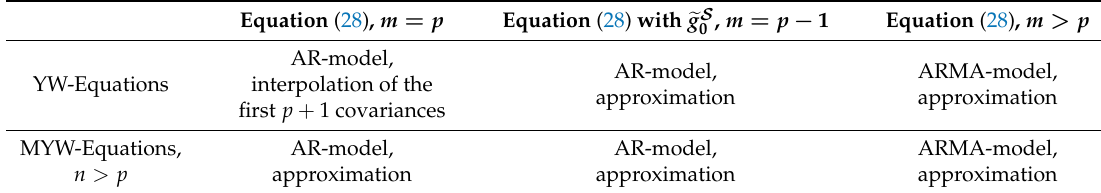
Table 1. Fitting procedures.